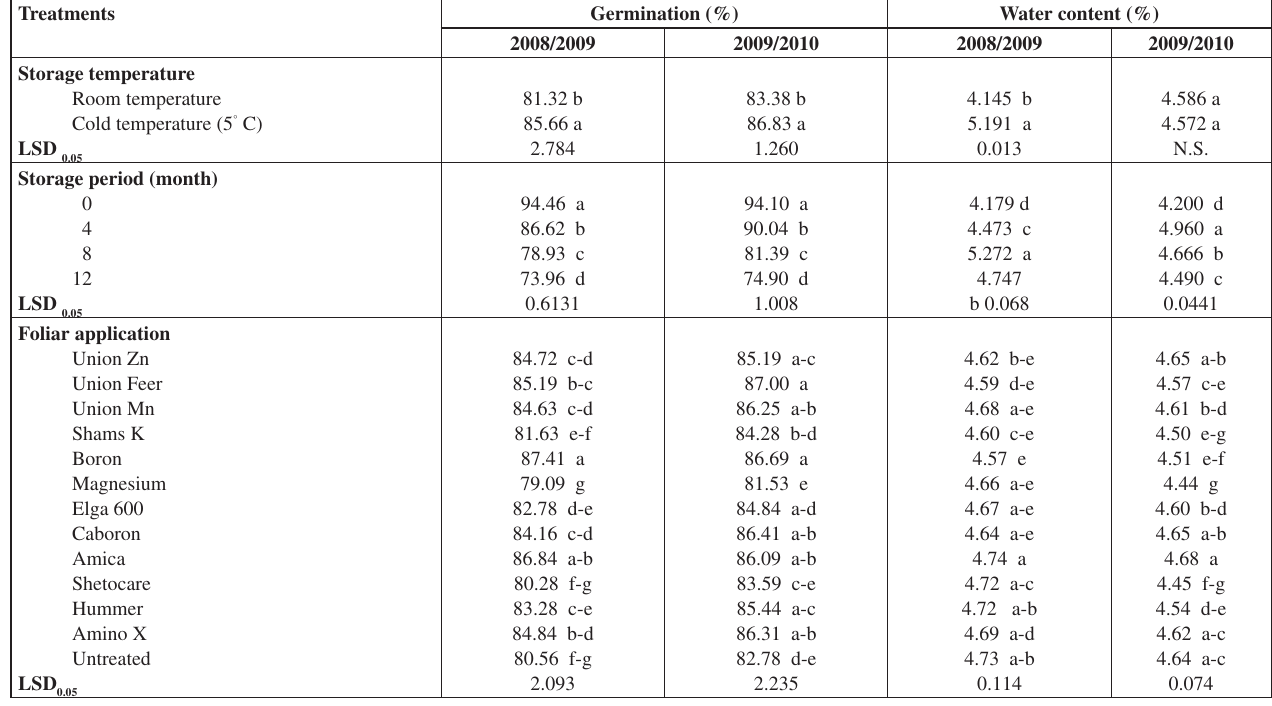
Table 6: Effect of storage temperature, storage period and foliar application with commercial compounds on germination (%) and water content (%) of onion seeds during seasons of 2008 / 2009 and 2009 / 2010 Treatments